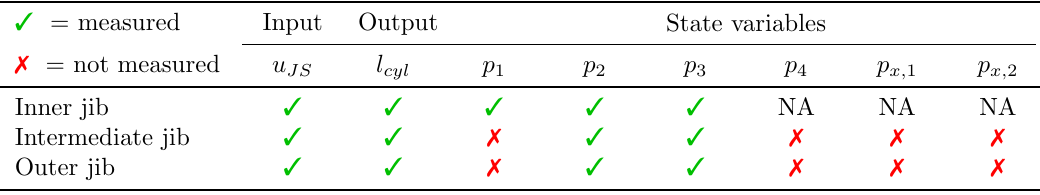
Table 1: System variables for considered motion control